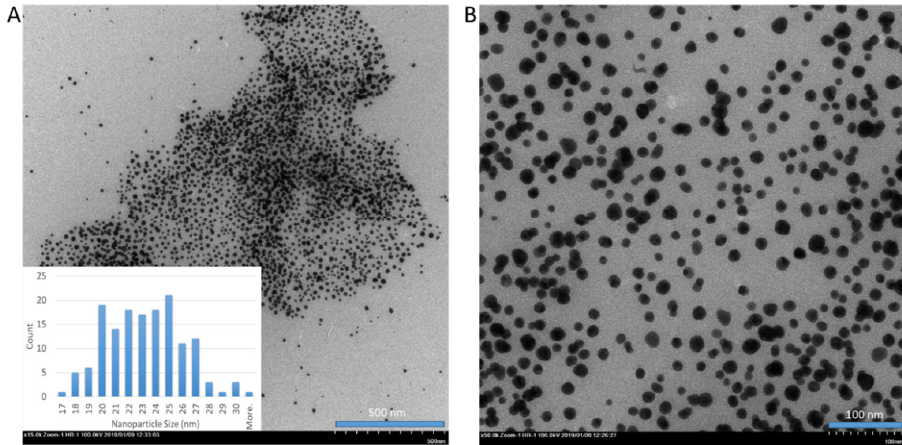
Figure 9. TEM micrographs of gold nanoparticles in toluene with hexylsilane as the phase-transfer molecule. (( A ) 15.0 k zoom. ( B ) 50.0 k zoom).